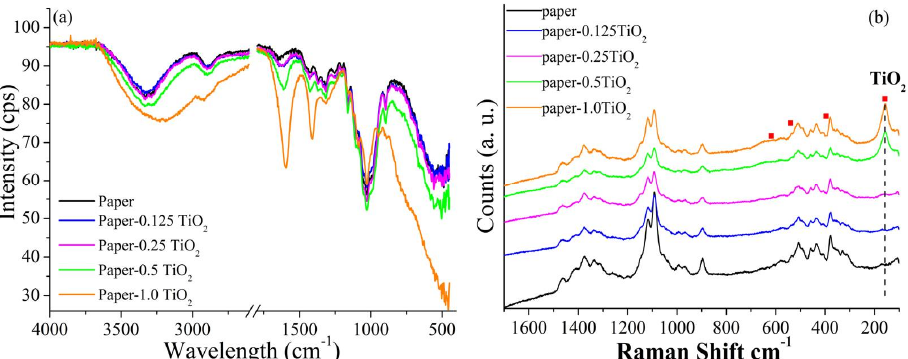
Figure 9. ( a ) FTIR spectra and ( b ) Raman spectra of TiO 2 -modified paper sheets with different loading of TiO 2 hydrosol.